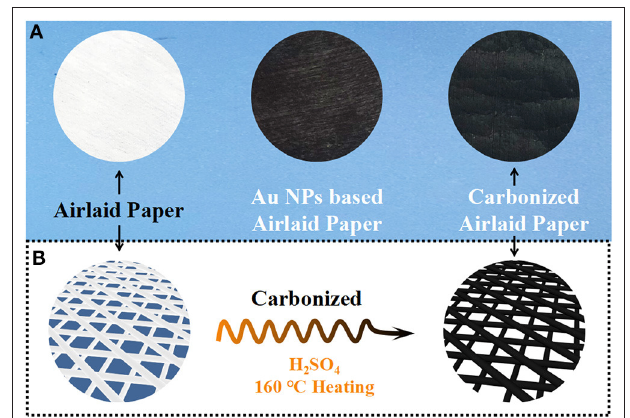
FIGURE 1 | (A) The photographs of APs, Au-APs and CAPs. (B) The fabrication process of the carbonized airlaid paper.